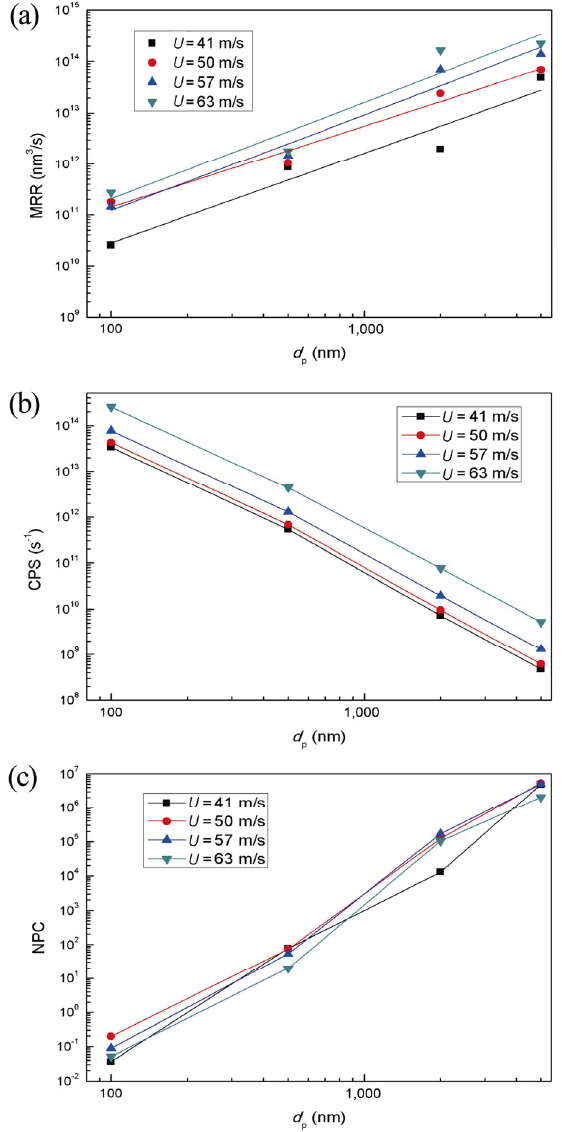
Fig. 5 Double-logarithmic plot of (a) the volume of material removal per unit time, (b) the total number of particle  surface collisions per unit time, and (c) the number of atoms removed per single collision versus the particle diameter d P